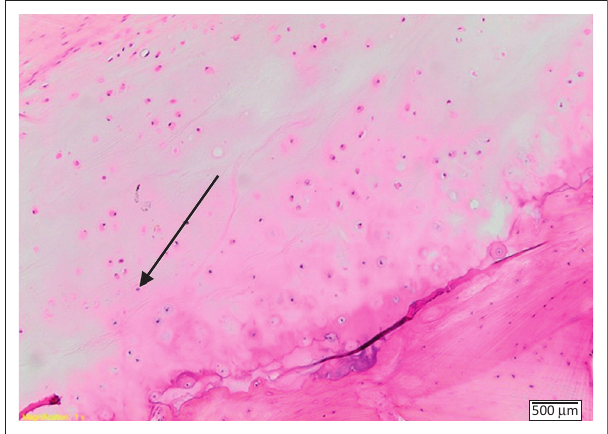
FIGURE 3: Haematoxylin and eosin staining, X 20 magnification. Well-formed hyaline cartilage cap (black arrow) overlying newly formed cancellous bone (white arrow), which contains fatty marrow.